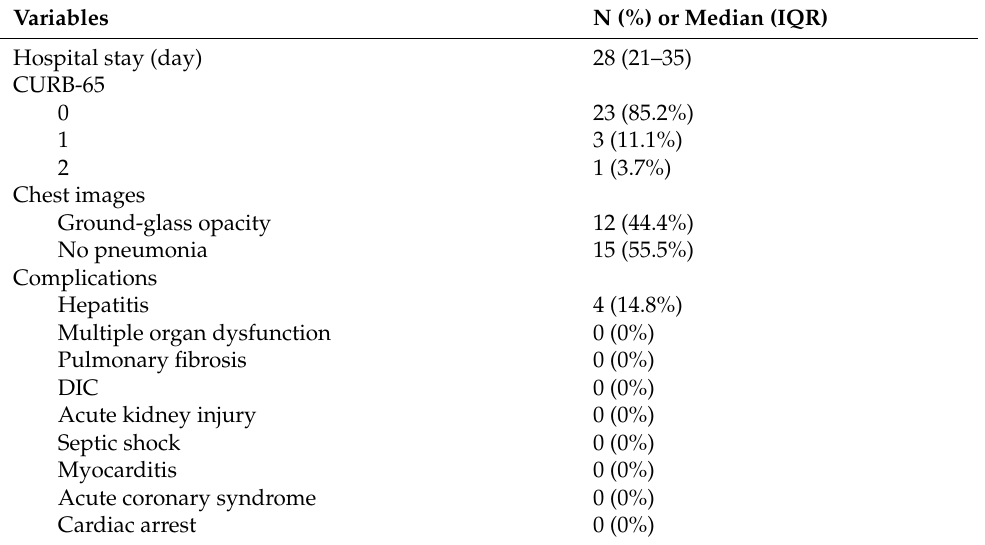
Table 2. Disease severity and complications ( n =